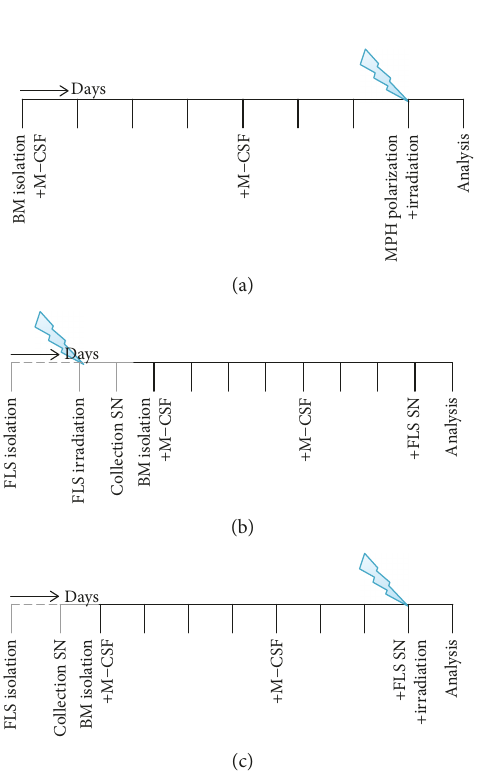
Figure 1: Visualization of experimental in vitro co-culture and radiation set-up. Experimental set-up for the assessment of cytokine-mediated (a) or supernatant- (SN-) mediated (b, c) macrophage polarization and the impact of LD-RT on it are displayed. In brief, fi rst, bone marrow-derived macrophages were generated and polarized using cytokines only (a). For the following experiments (b, c), prior to macrophage generation, fi broblast-like synoviocyte (FLS) cultures were generated and SN were collected from either irradiated (B) or untreated (C) FLS cultures and stored at -80 ° C. For experimental set-ups (a) and (c), macrophages were irradiated 2h after the addition of polarization medium, and for experimental set-up (b), macrophages were treated with SN of irradiated FLS only. 24h after the addition of polarizationmedia ± irradiation , macrophage phenotypes were